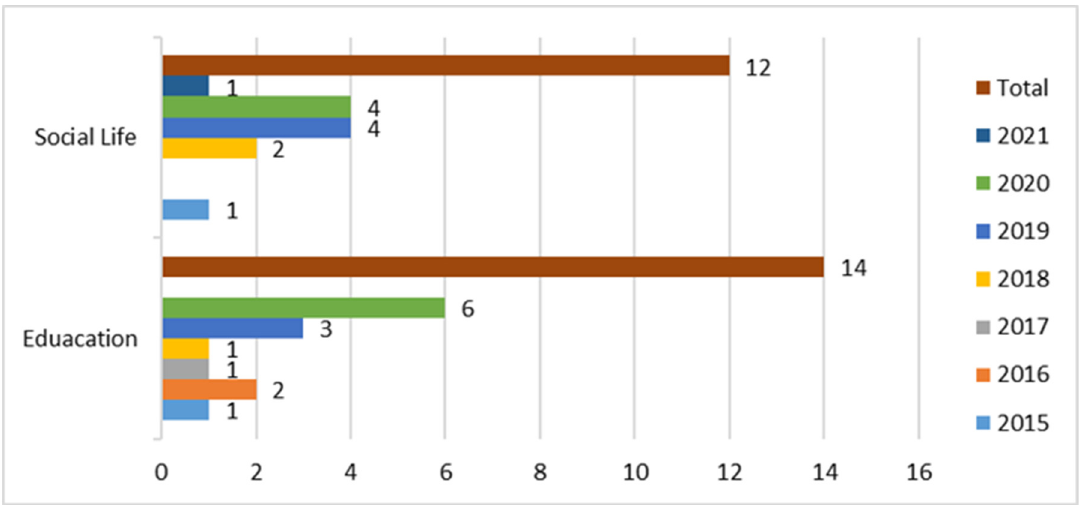
Figure 9. Number of primary papers based on the social life and education of BVI individuals (in years).